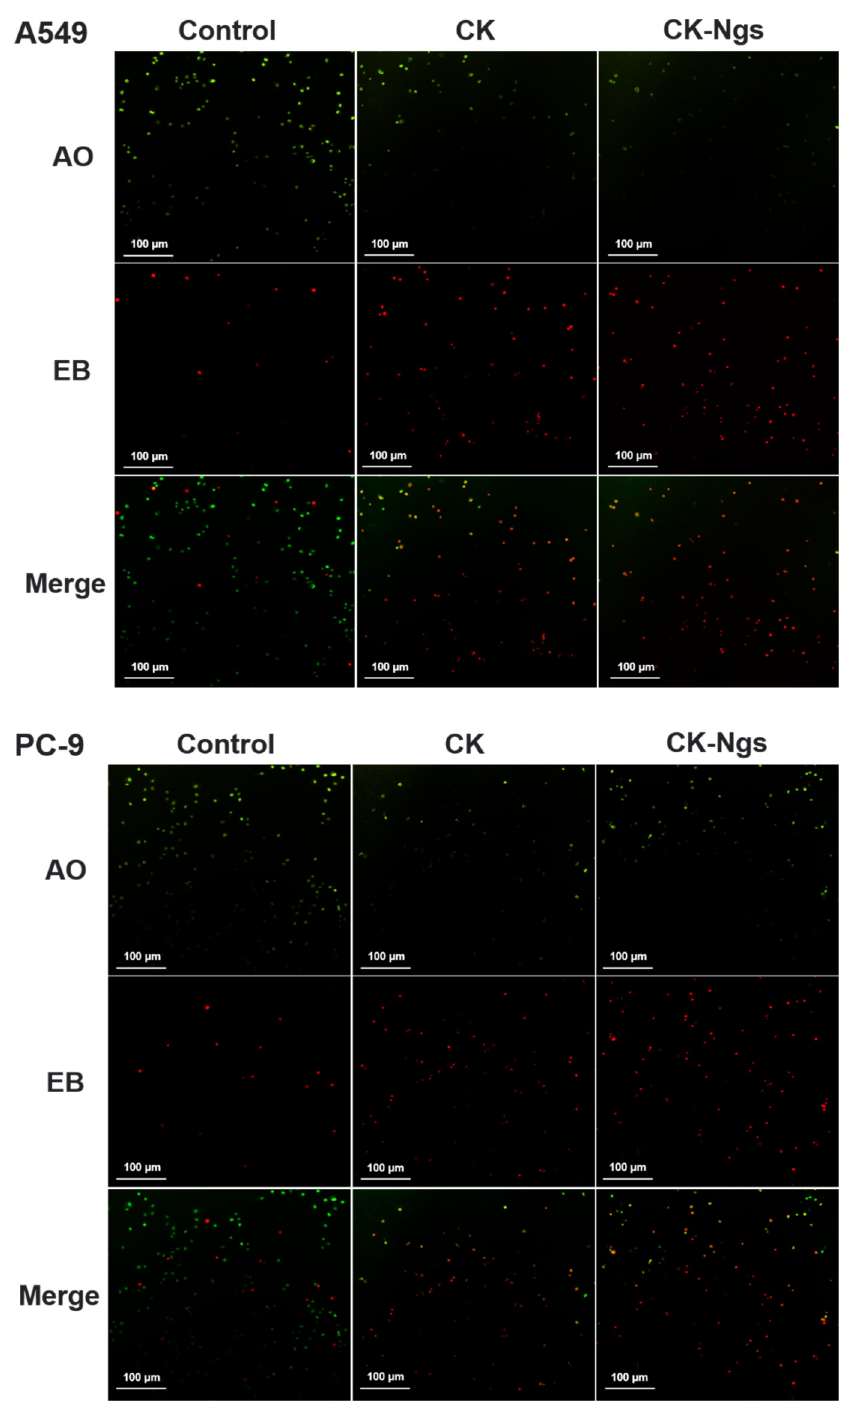
Figure 9. The cell apoptosis induction of CK and CK-Ngs in A549 and PC-9 cells were analyzed by AO/EB staining (Magnification 20× and scale bar is 100 μ m).